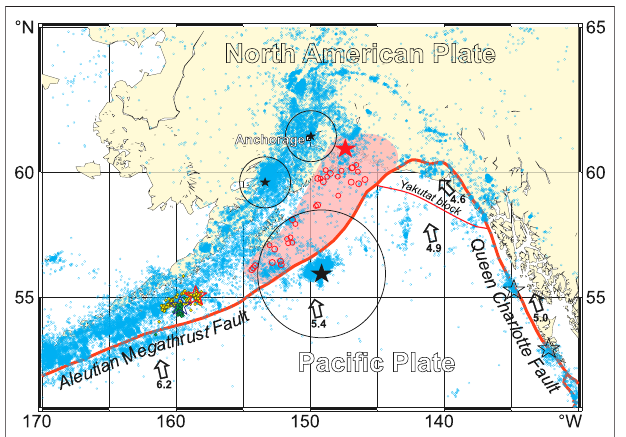
FIGURE 1 | Epicenters of the M ≥ 2.5 earthquakes (ANSS, 2006 – 2019; small blue circles) and the three major earthquakes (black stars) in Southern Alaska. Note: The two major earthquakes of M W 7.1 and the one of M W 7.9 under study are encircled with R (cid:1) 1 ° and 2.5 ° circles, respectively. Red line marks the boundary of the North American and the Paci fi c plates. The epicenters of the 1964 Great Alaskan earthquake (big red star) and its fi rst aftershocks(redcircles) aregivenontopthesubsurfacerupturezone(shaded pink). The epicenters of the 22 July 2020, M W 7.8 (red outline star) and its fi rst day M ≥ 2.5 aftershocks (small yellow circles) at 105 km SSE of Perryville, Alaska and the 19 October 2020, M W 7.6 earthquake at 97 km SSE of Sand Point, Alaska (blue outline star) and its fi rst day aftershocks (small green circles) occurred after the manuscript submittal and acceptance, correspondingly. The directions and rates (in cm/year) of Paci fi c plate convergence are indicated by the arrows.